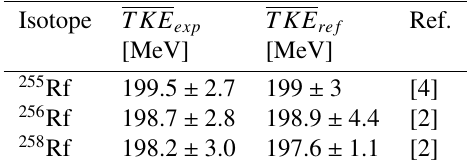
Table 1. In the table columns, from left to right, the isotope, TKE evaluated in this work, reference value of TKE and corresponding references are